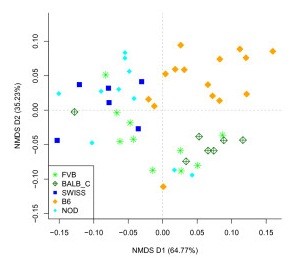
NMDS plot of enteroype 1 stratified sample set at the phylum level. Samples are colored by mouse genotypes and the percent of variation explained by each axis is indicated in parentheses.